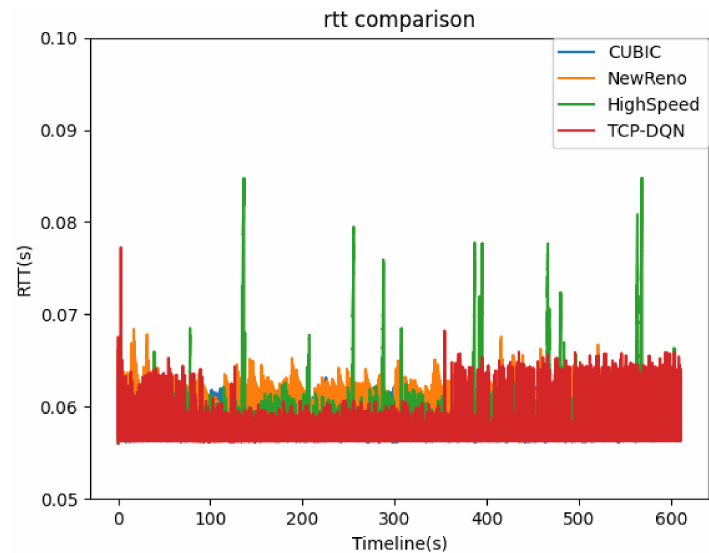
Figure 6. RTT comparison.